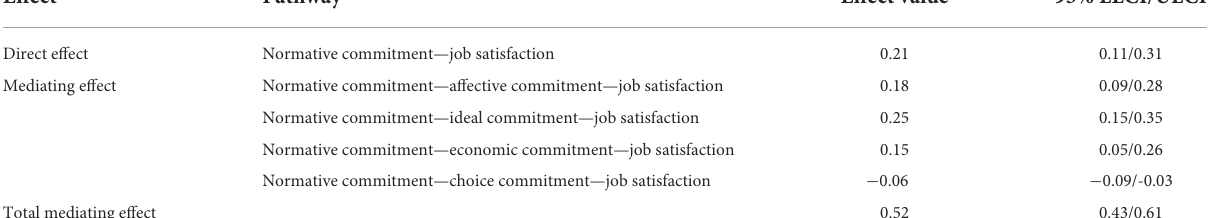
TABLE 3 Mediation analysis.